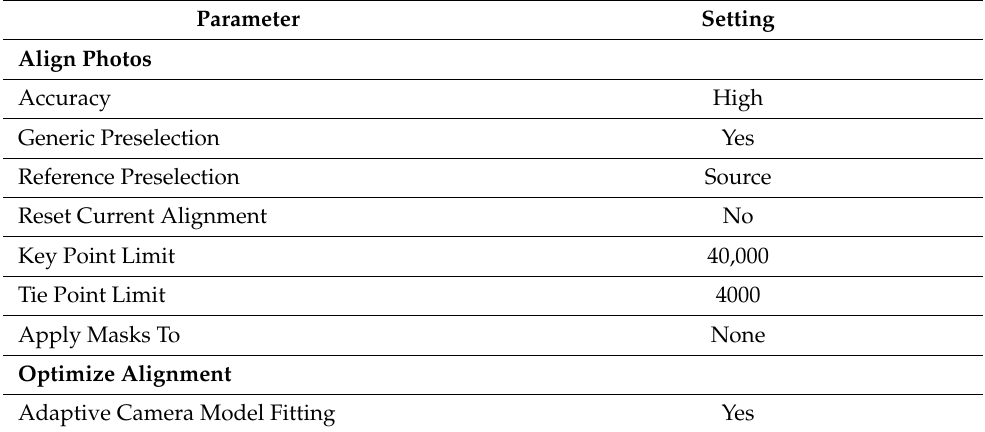
Table 1. Agisoft Metashape processing settings for image alignment and sparse cloud